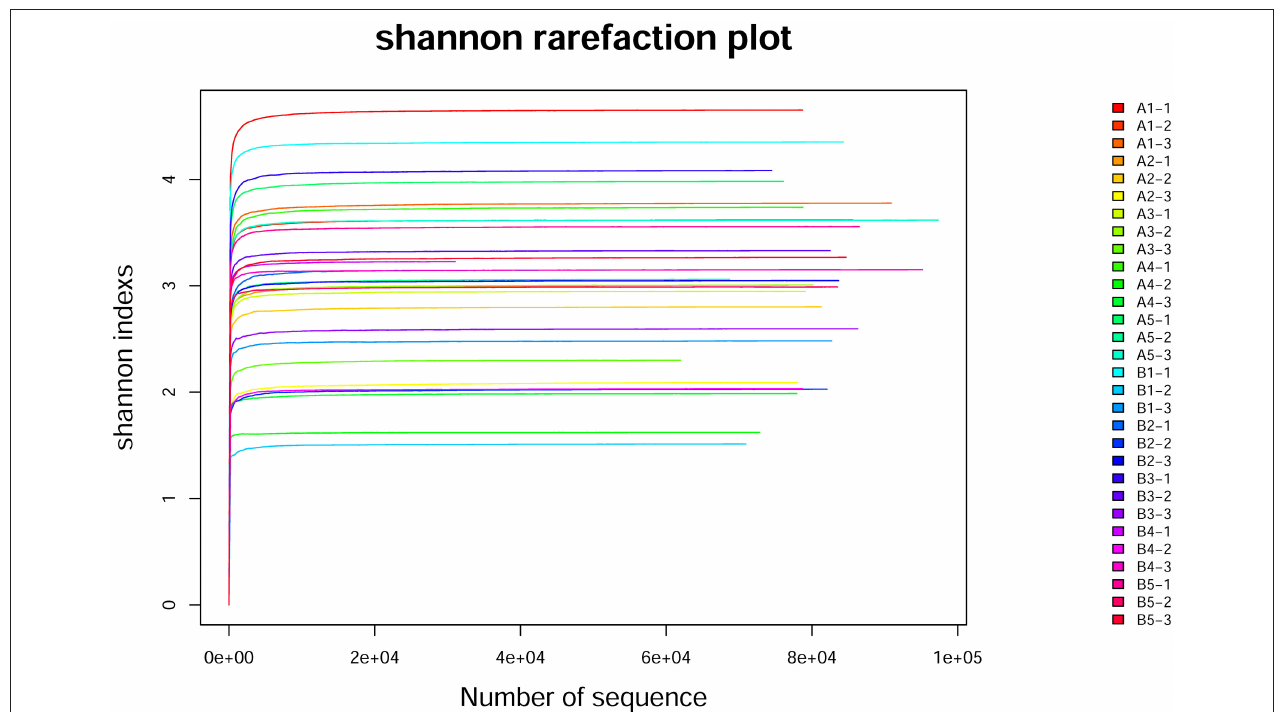
FIGURE 3 | Shannon rarefaction plot curve. The horizontal axis is the number of randomly selected sequences in the sample, the vertical axis is the corresponding Alpha index obtained, and each curve is a sample. A1-1, A1-2, A1-3, A1-4, and A1-5 indicate that group A1 was sequenced three times; B1-1, B1-2, B1-3, B1-4, and B1-5 indicate that group B1 was sequenced three times.